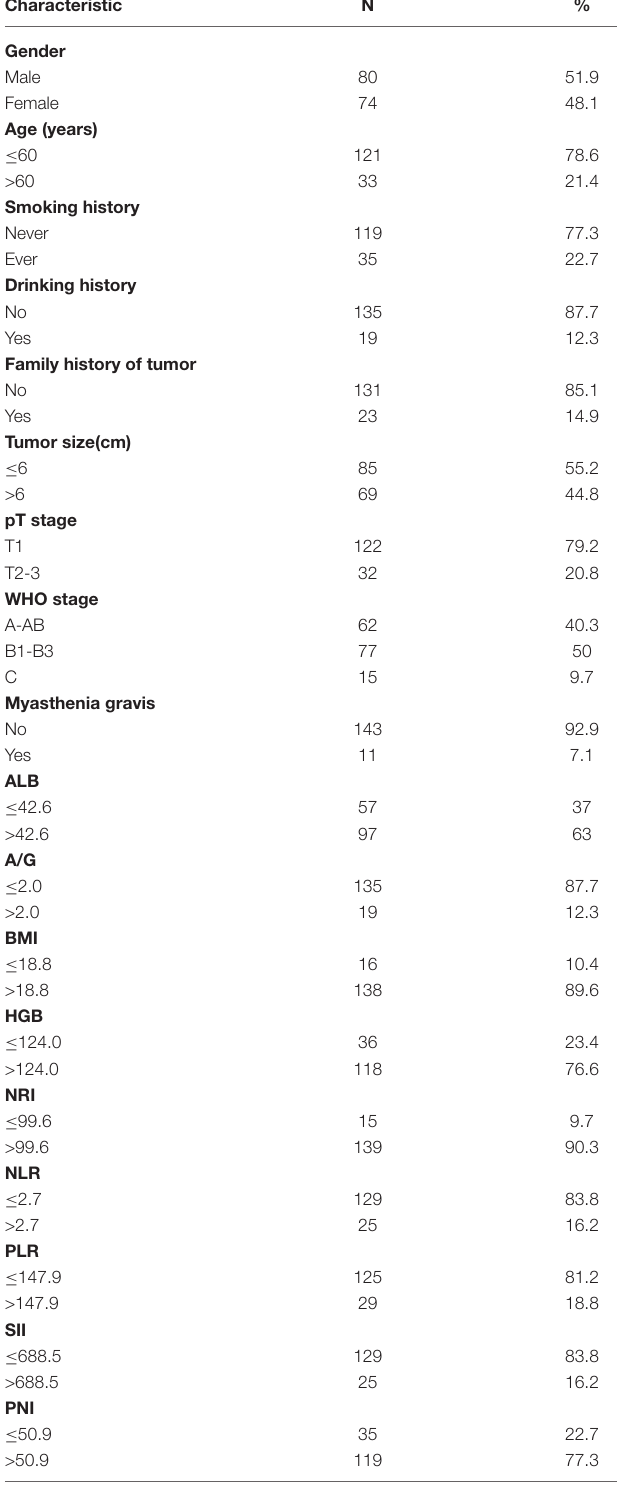
TABLE 1 | Patient and tumor-related characteristics of thymic tumor ( n =